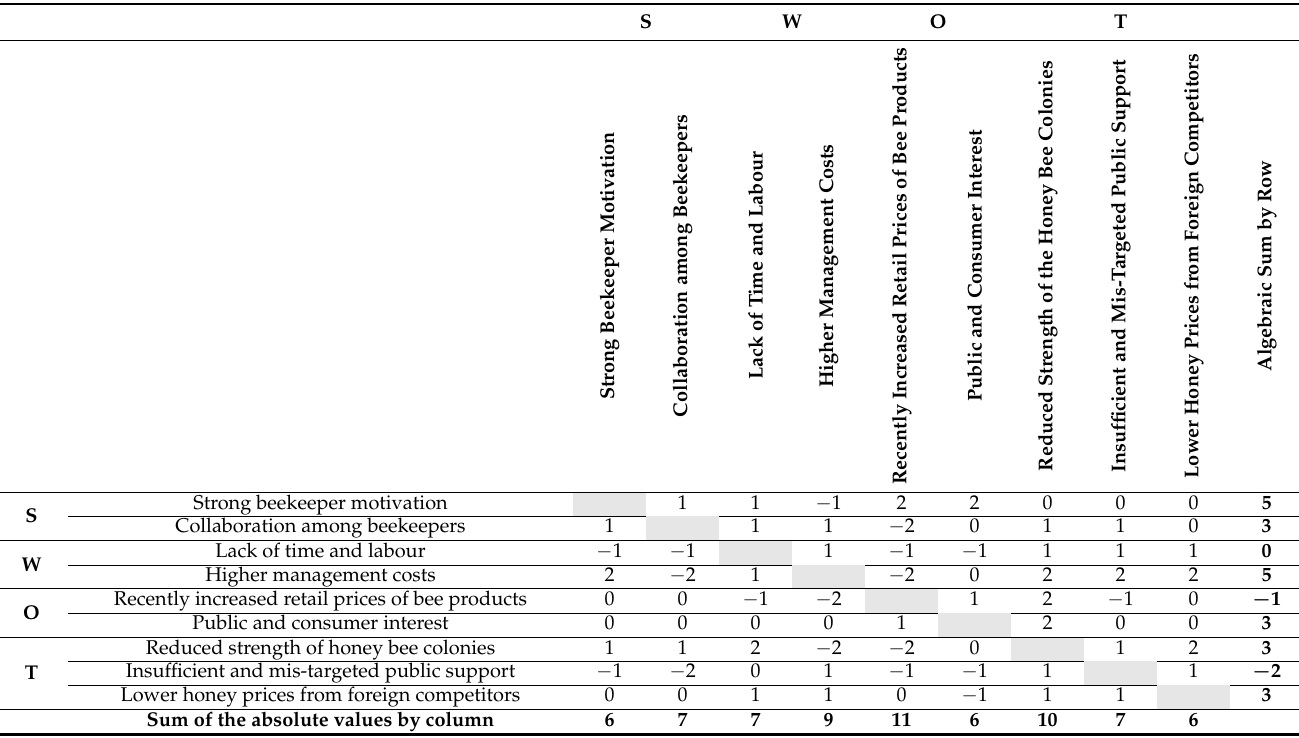
Table A3. Pairwise comparison of the SWOT items by